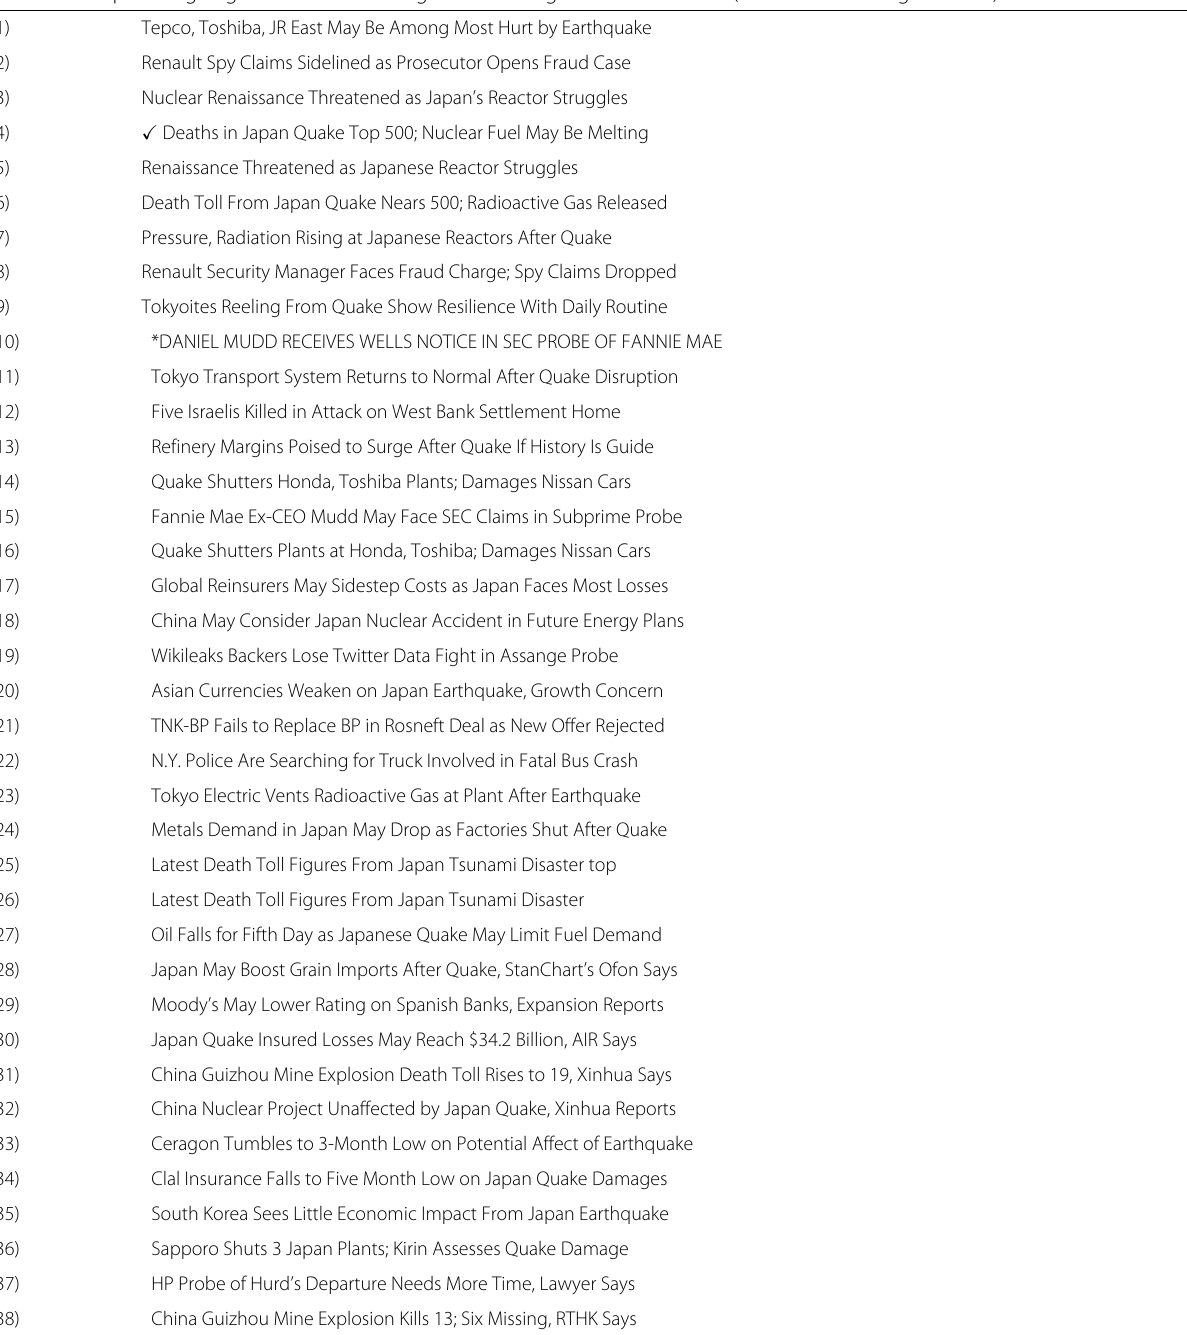
Table A3 Top ranking negative news according to Bloomberg on March 13 2011. (Source: Bloomberg